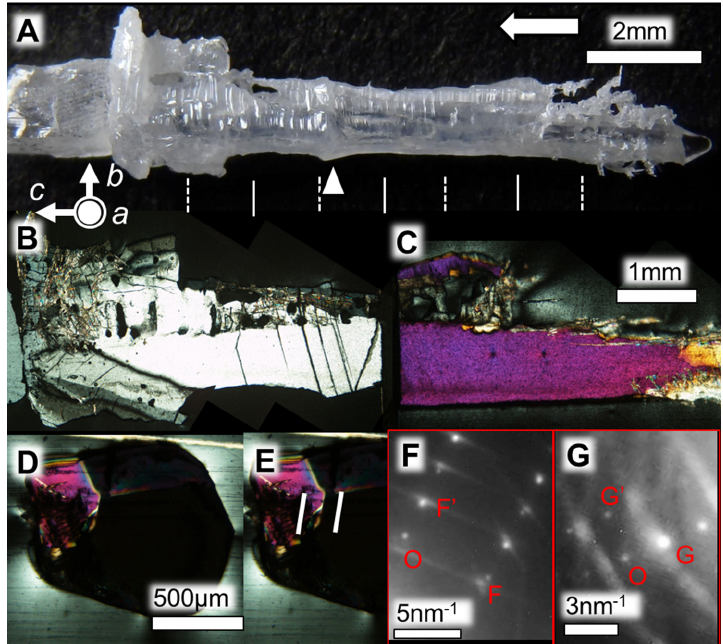
Figure A1. SBO crystal fibers grown at 800 V/cm: ( A ) external form of SBO crystal fibers; ( B , C ) po- larized optical microscope image of the SBO crystal taken under crossed Nicols; ( D ) cross-sectional view of the crystal fiber at the white arrowhead position of ( A ) ( A portion between ( B , C )); ( E ) parts processed by FIB for the TEM/SAED observation (white lines); ( F ) electron diffraction pattern of the domain at the left of ( E ); ( G ) electron diffraction pattern of the domain at the right of ( E ). Symbols in ( A ) correspond to the crystallographic orientation of seed crystals. A white arrow corresponds to the pulling-down direction. Alternating timing of electric fields corresponded to solid lines (electrodes in the melt, +; growth fronts, − ) and dashed lines (electrodes in the melt, − ; growth fronts,